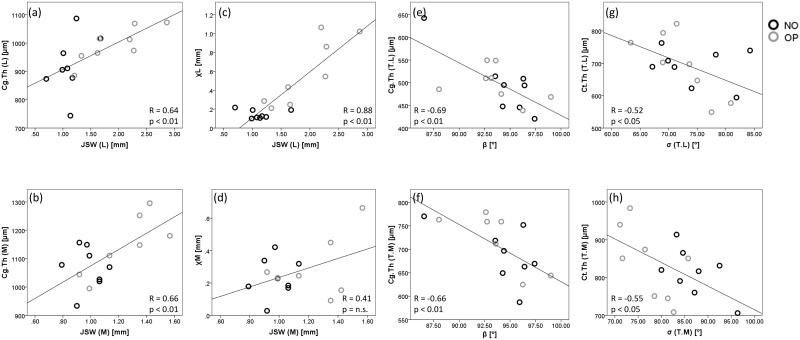
Bivariate Regressions of QMA measures.Relationships between QMA measures indicate significant associations between and within tissue measures (Cg.Th, Ct.Th) and whole joint measures (JSW, χ, β, σ). Correlations were observed between Cg.Th and JSW both (a) laterally (R = 0.64, p < 0.01) and (b) medially (R = 0.66, p < 0.01), where Cg.Th is the addition of mean tibial and femoral compartmental values. This was also seen laterally (c) but not medially (d) for JSW and χ (R = 0.88, p < 0.01). The β angle is strongly negatively correlated with both (e) lateral and (f) medial tibial Cg.Th (R = -0.69 and -0.66, respectively, p < 0.01), and Ct.Th is negatively correlated with σ in the (g) lateral and (h) medial tibia (R = -0.52 and -0.55, respectively, p < 0.05).